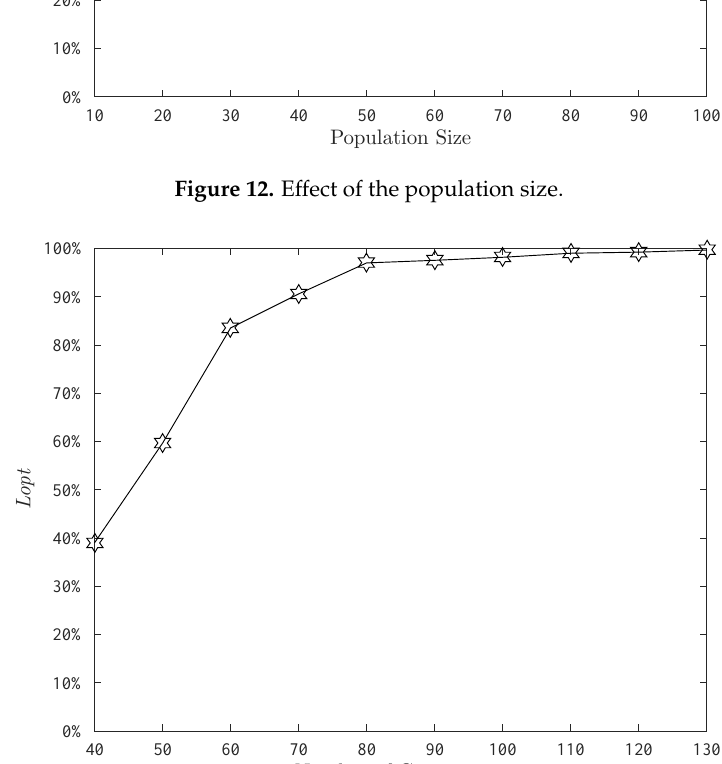
Figure 13. Effect of the number of